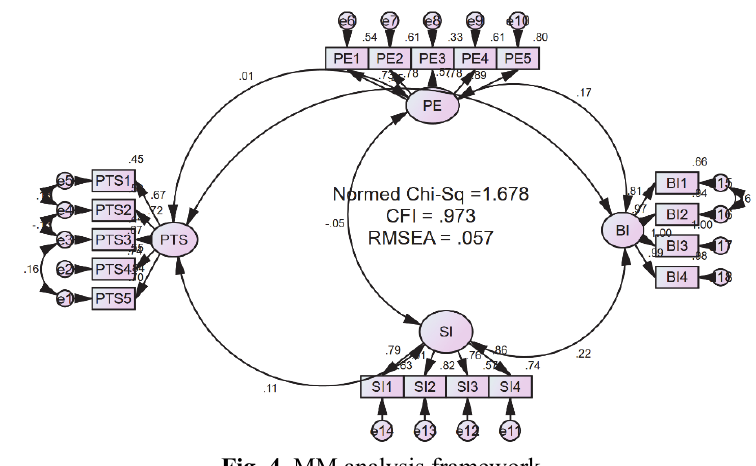
Fig. 4. MM analysis framework